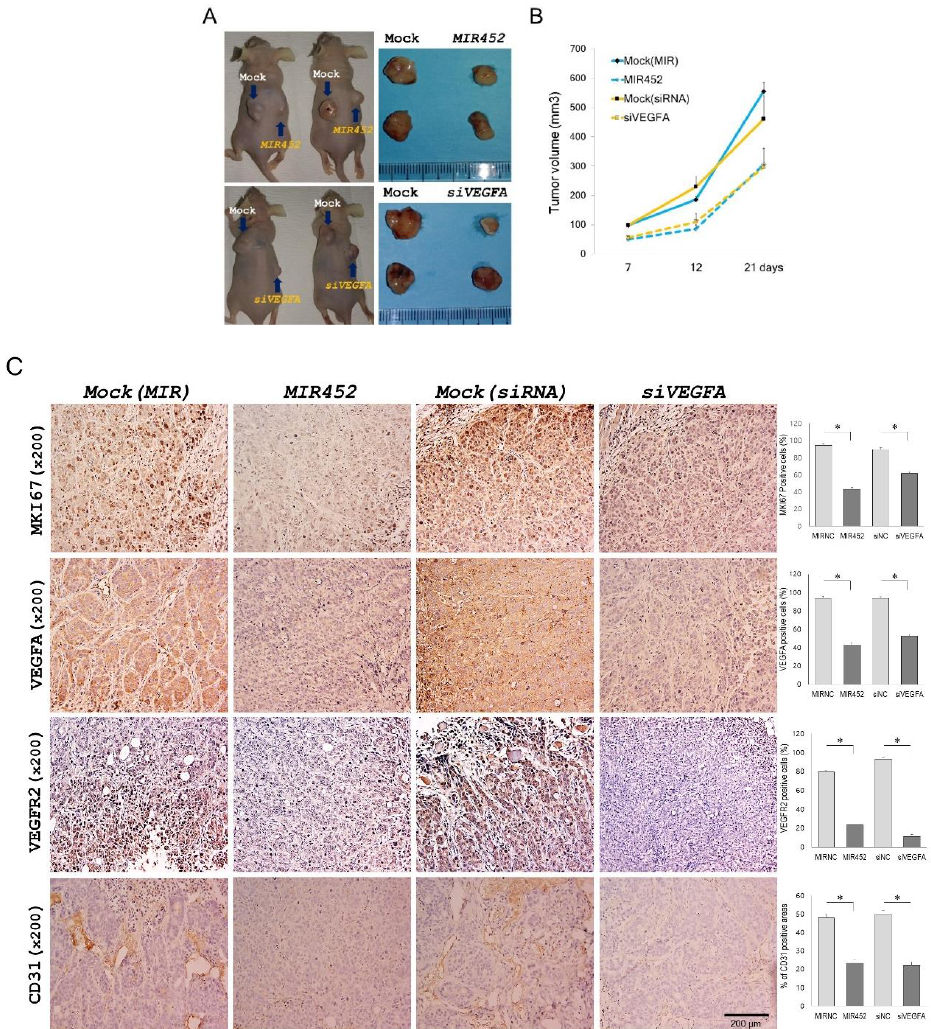
Figure 6. MIR452 inhibited CRC cell growth and angiogenesis in the xenograft model. ( A ) MIR452 inhibited CRC cell growth in vivo. An image of xenograft tumors derived from HT29 cells transfected with the MIR452 mimic or mock control (upper panel), and the siVEGFA or mock control (bottom panel). ( B ) Volumes of the xenograft tumors derived from HT29 cells transfected with the MIR452 mimic, siVEGFA , or mock controls in nude mice. ( n = 8, mean ± SD). Three independent experiments were performed using 2–3 mice per experiment. ( C ) Expression of the cell proliferation marker MKI67 (the top column), VEGFA (the second column from the top), VEGFR2 (the third column from the top), and endothelial cell marker CD31 (the fourth column from the top) in the xenograft tumors formed after subcutaneous transplantation of HT29 cells transfected with the MIR452 mimic, siVEGFA, or mock controls (200 × magnification). Three independent experiments were performed in duplicate, and the p -values were calculated by using Student’s t -test (* p <